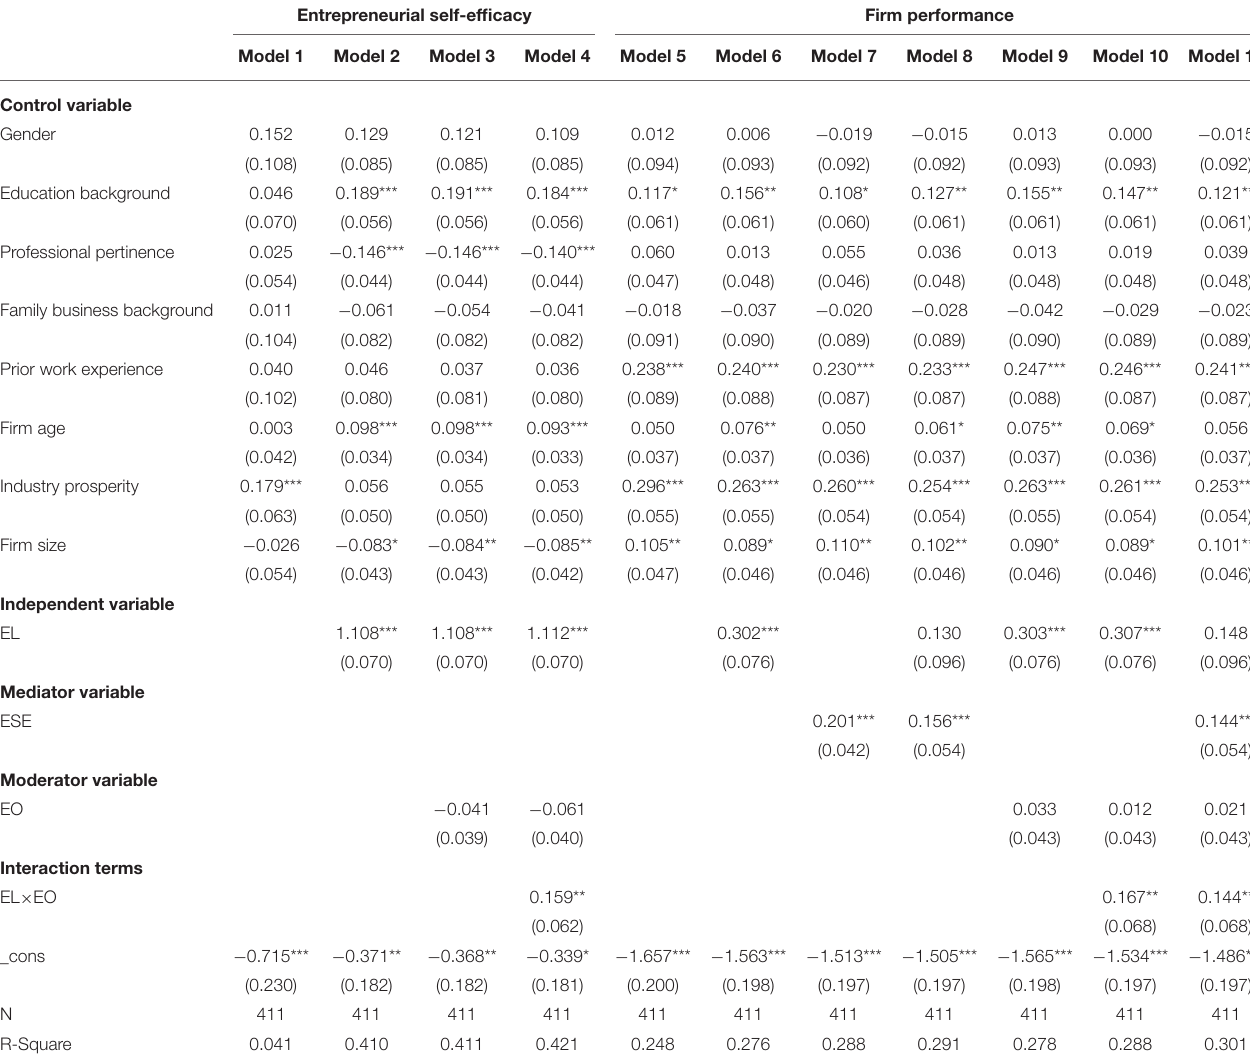
TABLE 3 | The hierarchical regression